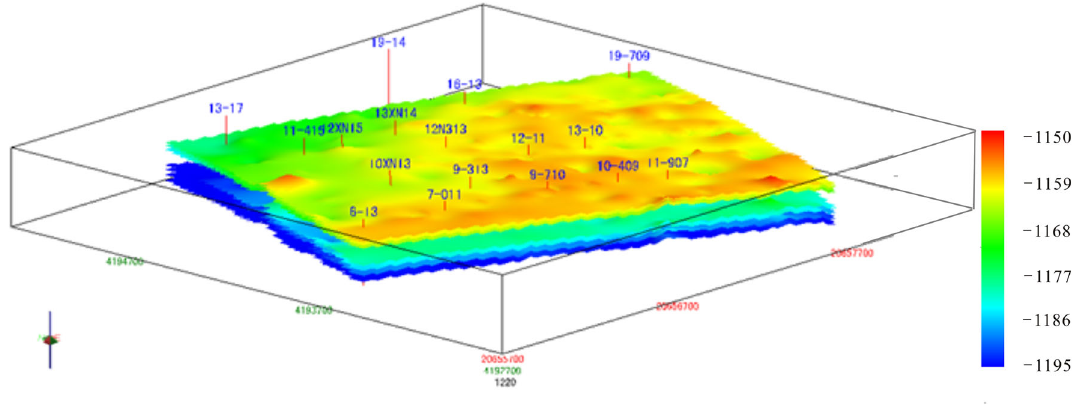
Fig. 8 Structure model of Ng3 sand group in the study area